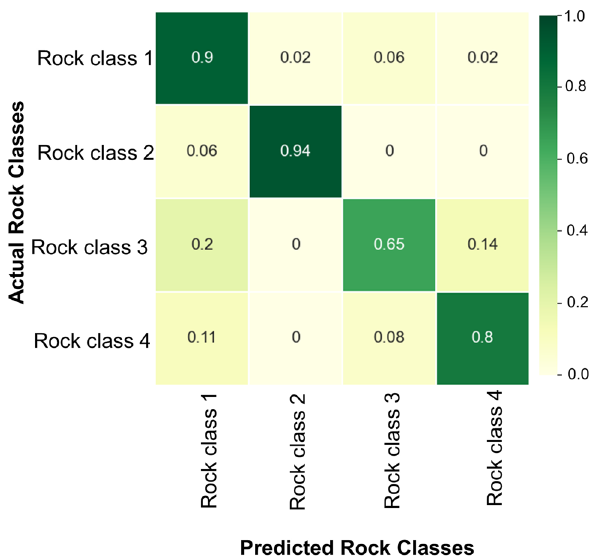
Fig. 15 Confusion matrix on the test set using the coarsened clas- sifier, where the original 20 lithofacies classes are merged into four rock